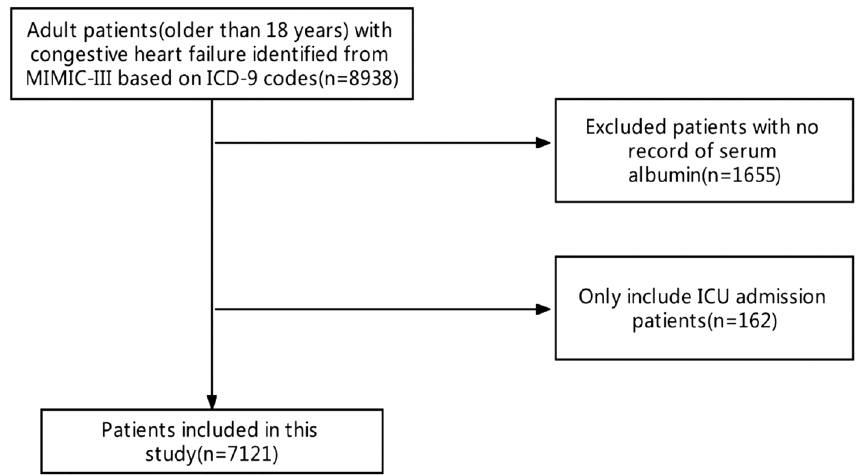
Figure 1. Flow diagram of patient included in the